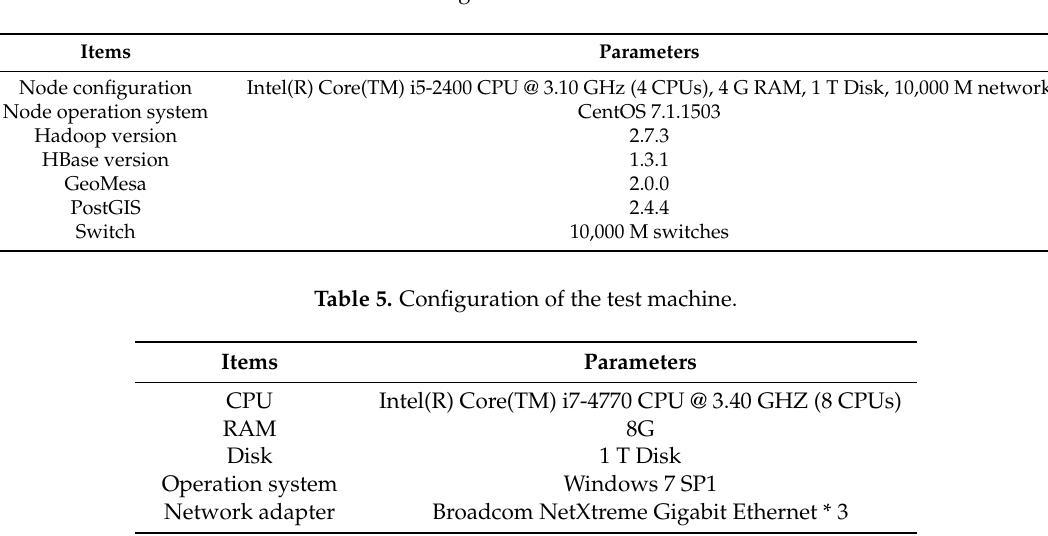
Table 4. Configuration of the server node.